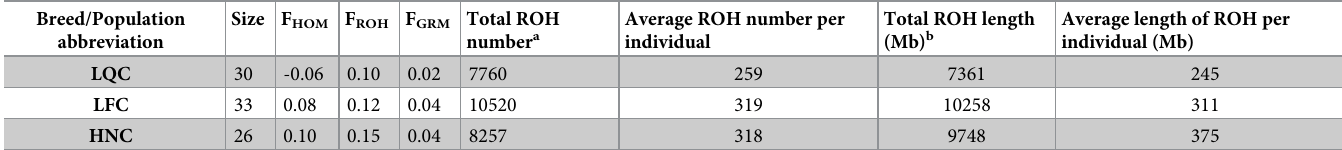
Table 1. The descriptive statistics of ROH for three Chinese indigenous cattle populations. Breed/Population